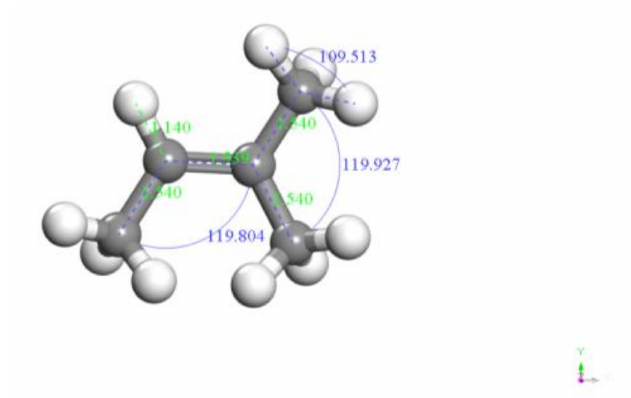
Figure 5. Geometrically optimized EUG